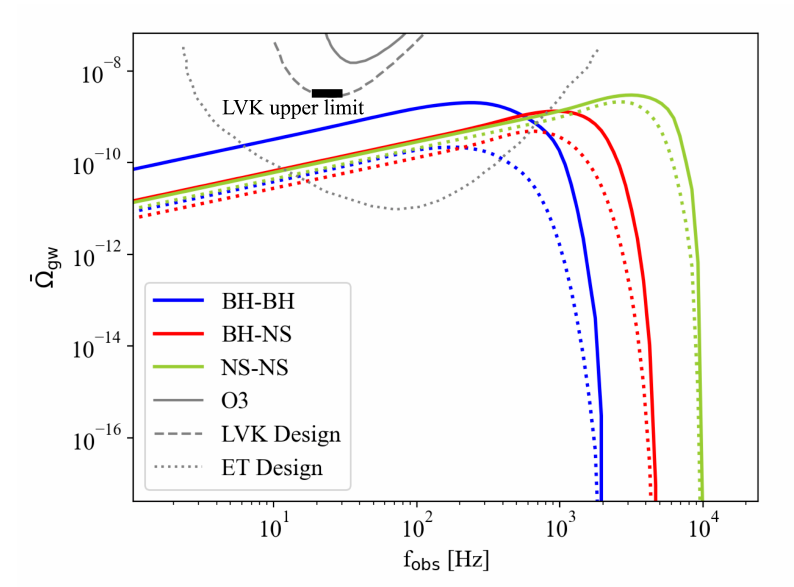
Figure A1. Isotropic SGWB energy density as a function of frequency for BH-BH (blue), BH-NS (red) and NS-NS (green). The solid curves represent the total background, given by the superposition of all the GW events, resolved and unresolved. The dotted curves, instead, represent the residual background for ET, obtained filtering out those events whose signal-to-noise ratio ρ is high enough to be resolved by the detector. The grey curves are the power-law integrated sensitivity curves [85] for ET and LIGO/Virgo/KAGRA O3 and design sensitivity, as specified in the legend. We also show the current upper limit on the isotropic SGWB: Ω gw ≤ 3.4 × 10 − 9 at 25 Hz for a power-law background with a spectral index of 2/3, expected for compact binary coalescences